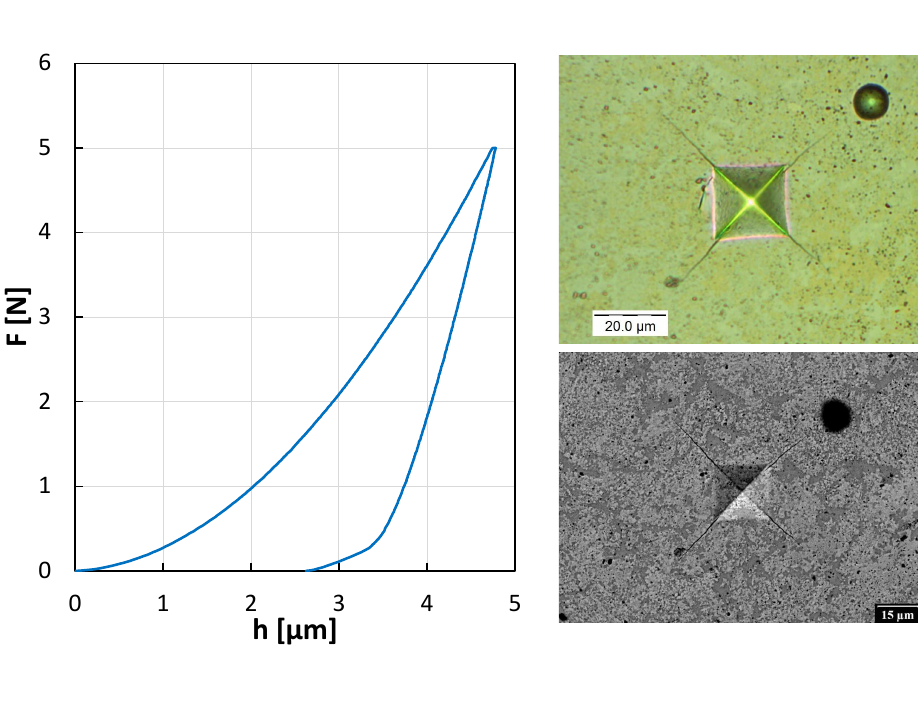
Figure 4. Indentation curve and the residual indent with Palmqvist and lateral cracks in FeSi_Al sample. Lateral cracks are visible on light optical micrographs.